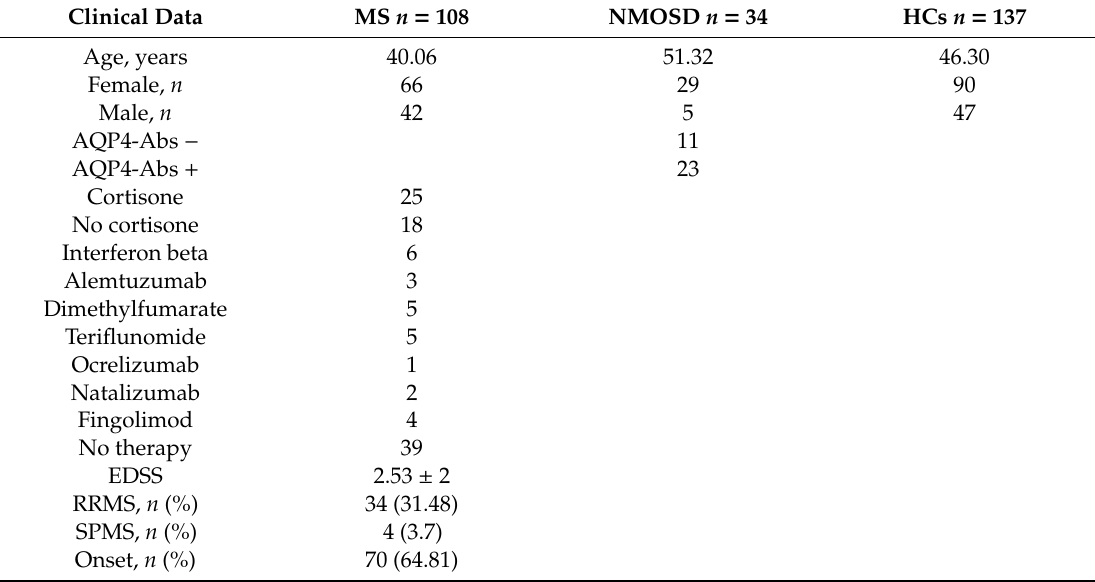
Table 1. Demographic and clinical characteristics of multiple sclerosis (MS) patients, neuromyelitis optica spectrum disorder (NMOSD) patients, and healthy controls